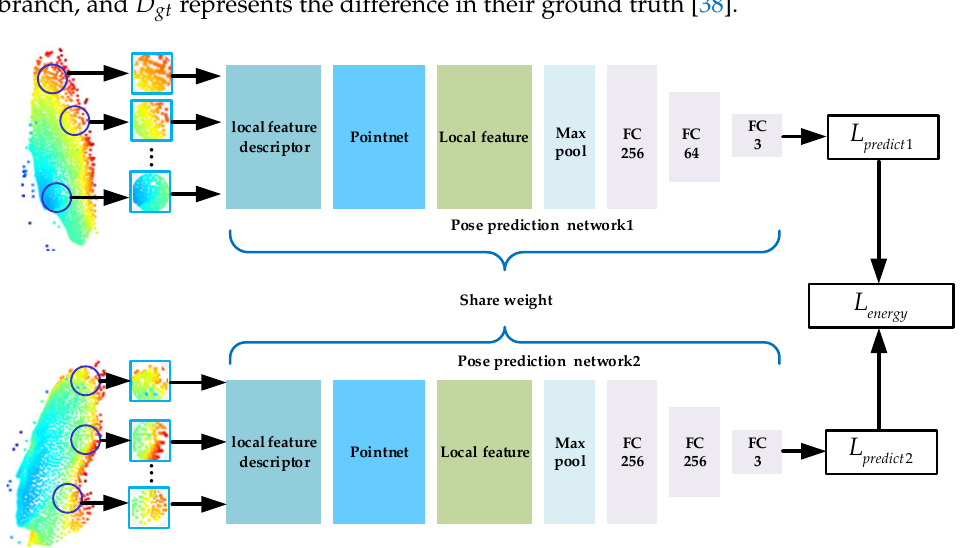
Figure 4. The structure of the Siamese network for head pose estimations. Two shared weight networks extract similar pose objects, and an energy function (the loss function of the Siamese network) concatenates the prediction results of two branches to constrain the prediction values and guide the regression